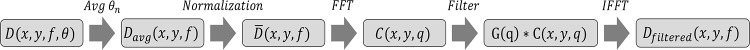
Signal processing flowchart.The flowchart describes the signal processing steps taken during the cepstrum analysis.